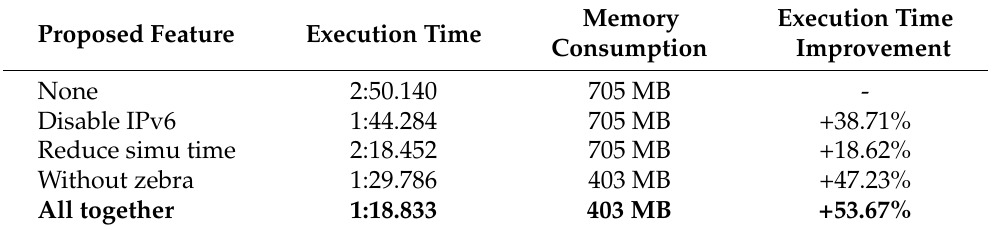
Table 2. Results of execute the scenario 6_6_6_link-failure-spine-tof after applying perfor- mance improvements.